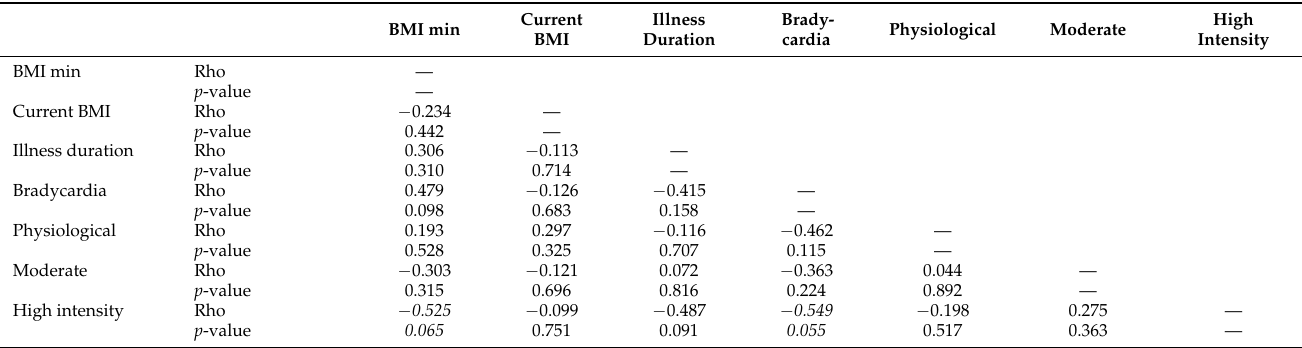
Table 6. Non parametric correlation for BMI min, current BMI, illness duration and heart rate ranges in partially recovered AN patients ( n = 13). Trend values are in italics. BMI: body mass index; EDI: Eating Disorder Inventory II; HADS: Hospital Anxiety and Depression scale; YBS: Yale Brown